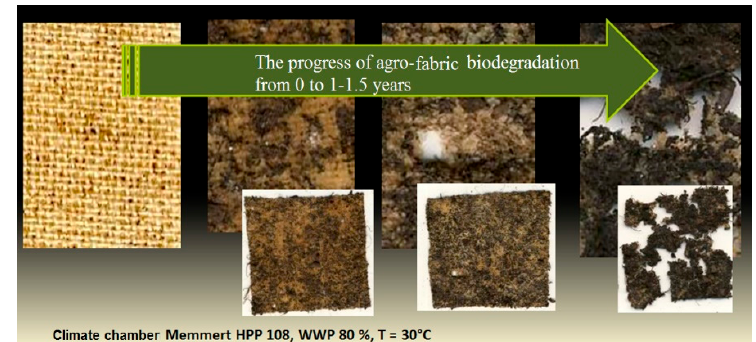
Figure 15. Progress of biodegradation the starch-cellulosic composite from 0 to 1–1.5 years.